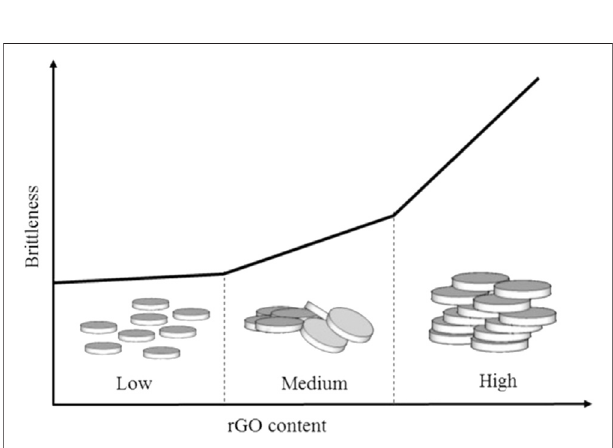
FIGURE 7 | Relationship between the amount of rGO and brittle properties (Saa fi et al., 2015).